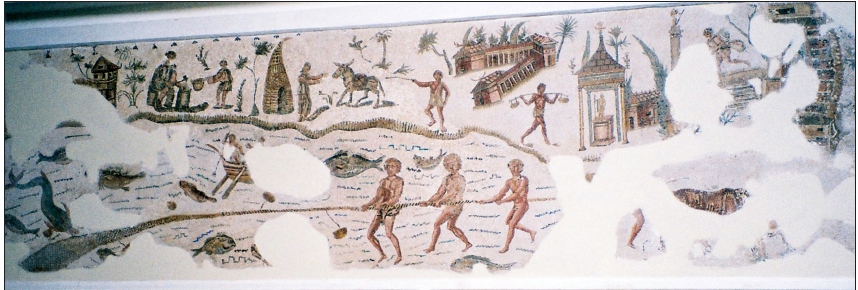
Figure 8: Mosaic from El Alia, with taskscape. (Photo: Verity Cridland, licensed under Creative Commons Attribution- 2.0 Generic